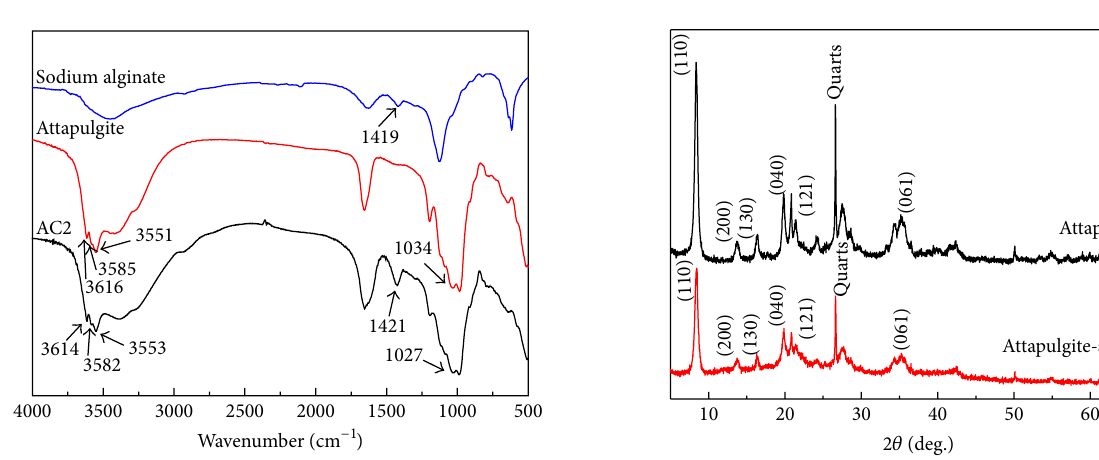
dispersion of attapulgite nanofibers on the shell compared to AC2 and AC3, which leads to low adsorption capacity of AC1.